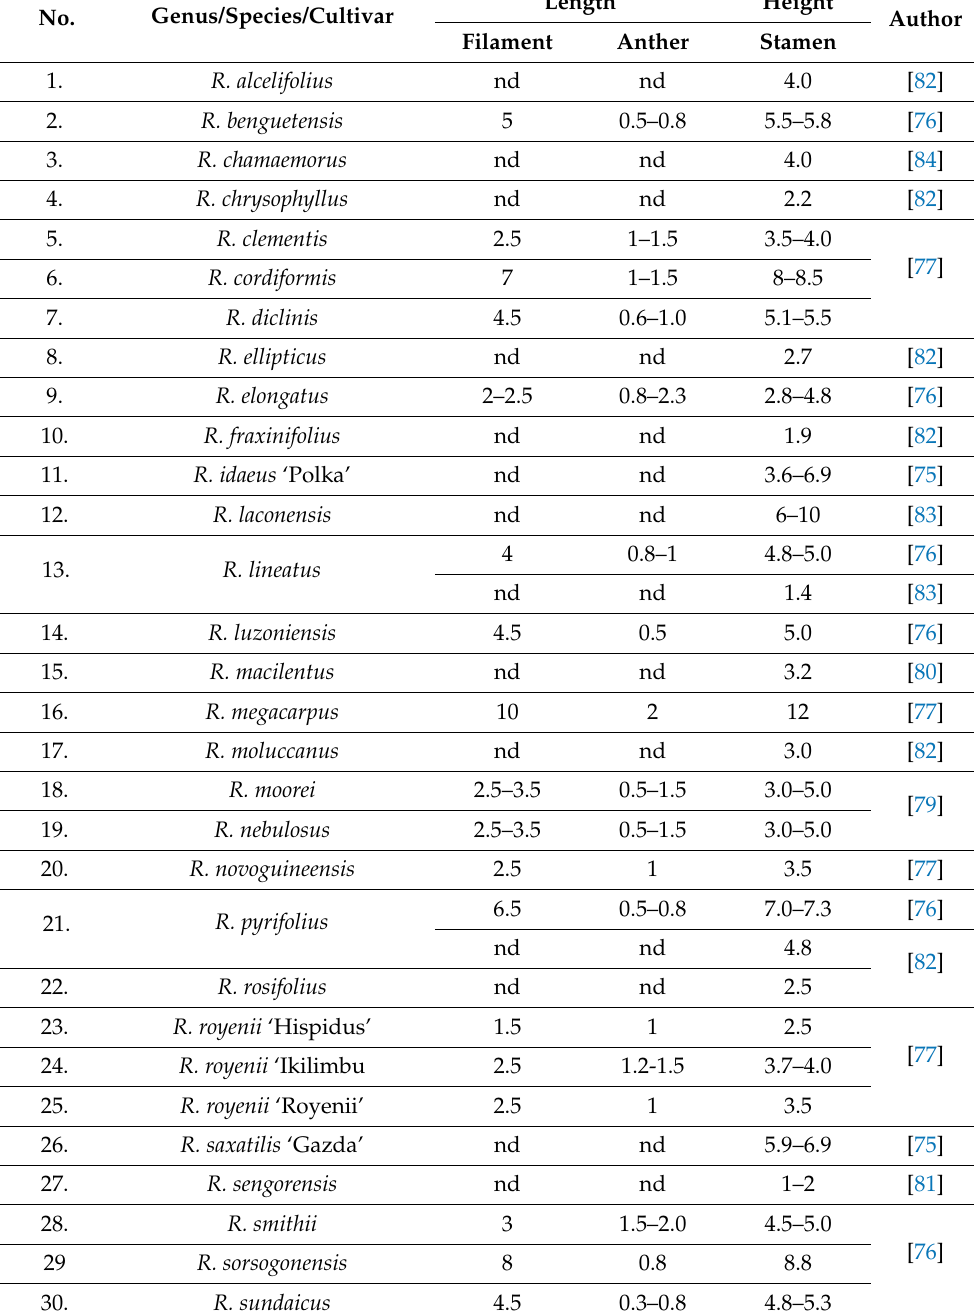
Table 6. Length of filaments and anthers and height of stamens in flowers of selected Rubus species. Length No. Genus/Species/Cultivar